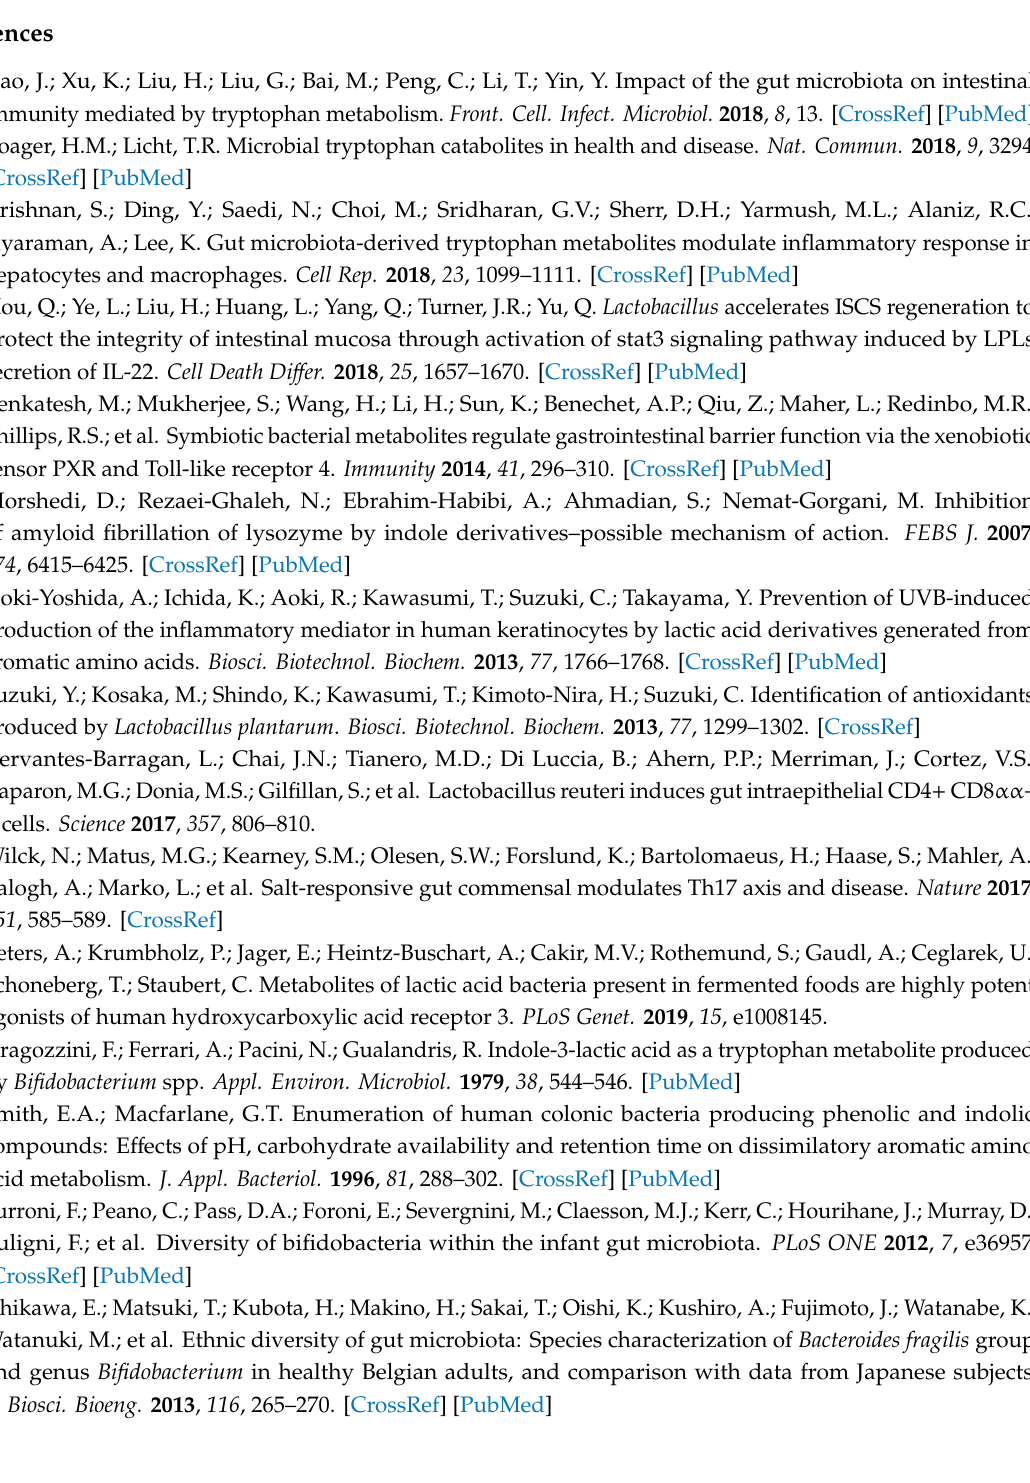
Figure S1: Production of tryptophan metabolites (IAld, IAA, and IPA) by 19 bifidobacterial strains, Figure S2: Production of ILA by 100 bifidobacterial strains., Table S1: List of tryptophan metabolites and the internal standard., Table S2: Production of ILA by 19 bifidobacterial